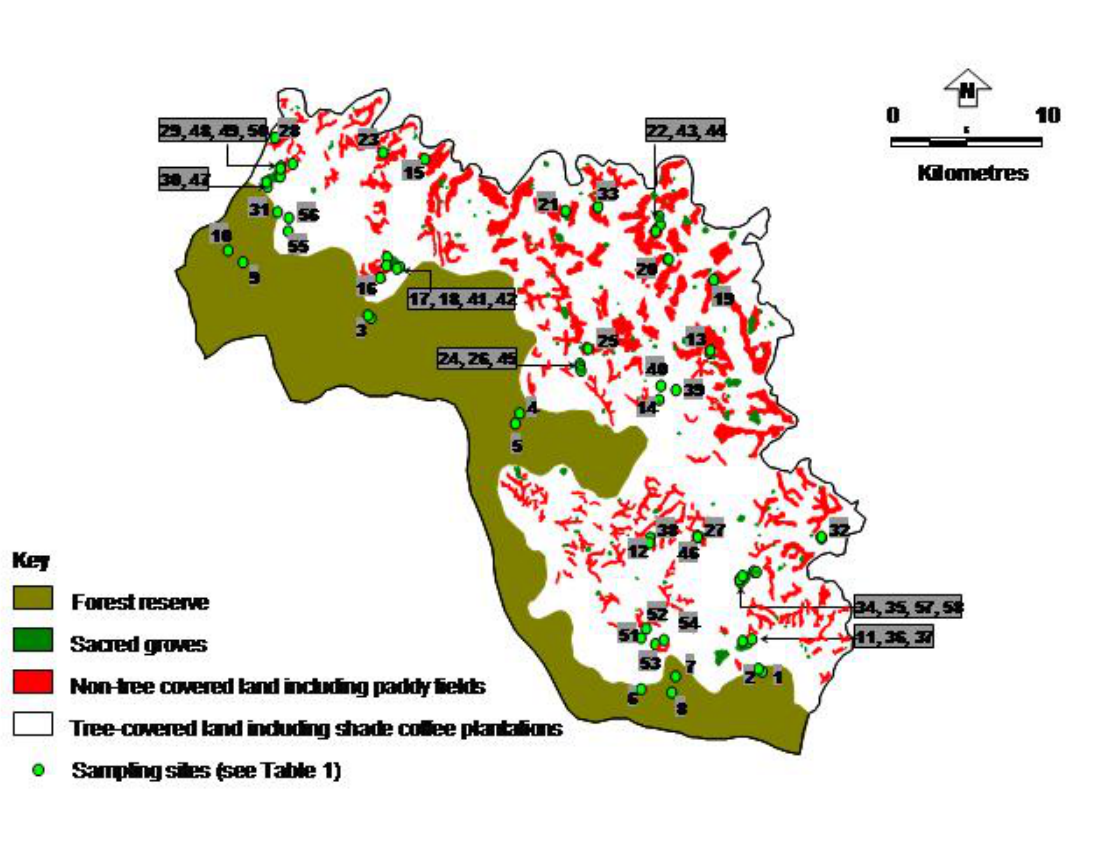
Fig. 2. Landscape map of the study area in Kodagu, Western Ghats of India, showing landscape composition and land uses studied; sampling sites are numbered according to the list in Table